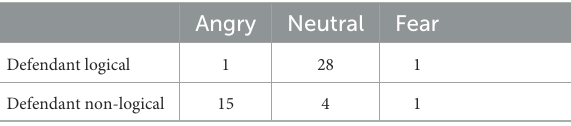
TABLE 3 The influence of voice at court on defendant’s